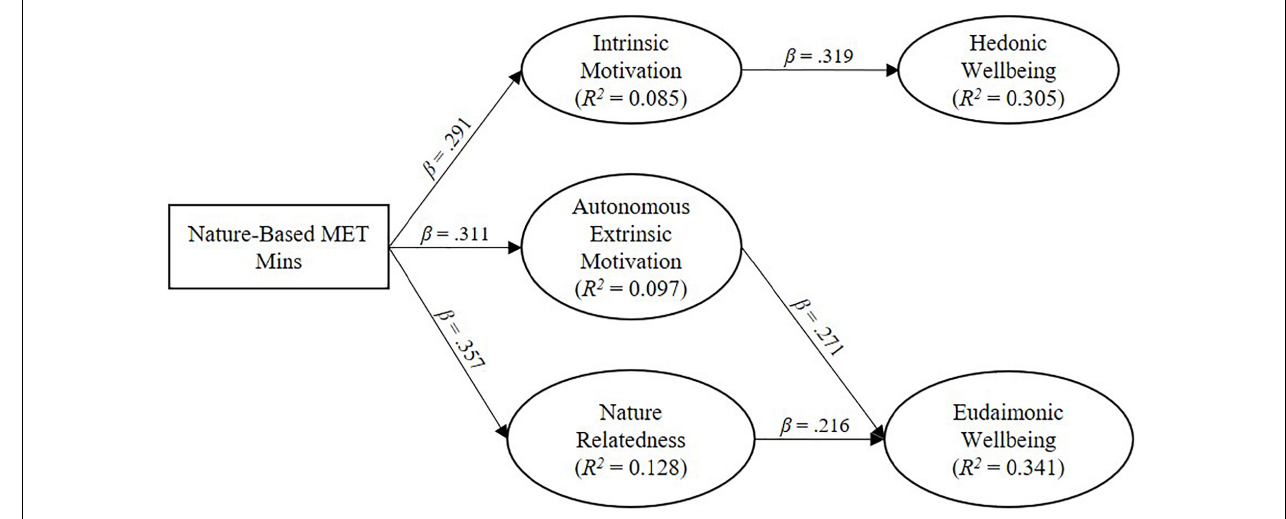
FIGURE 2 | Figure showing only significant positive